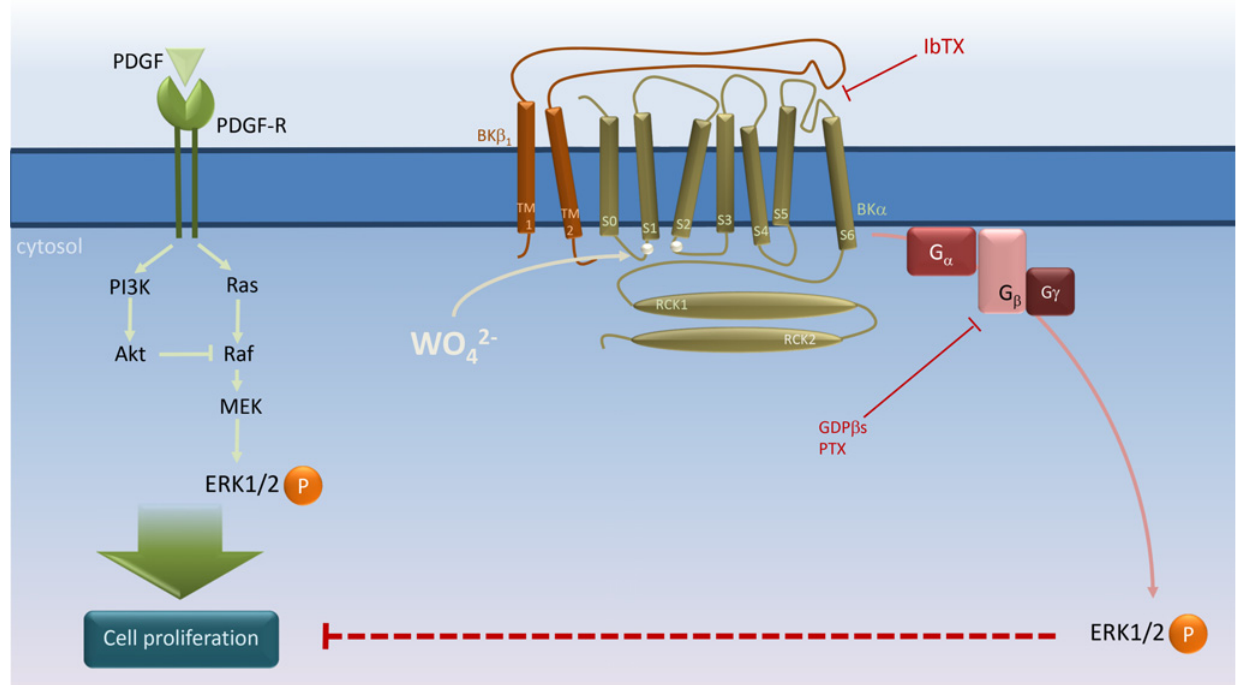
Fig 6. Schematic representation of BK αβ 1 channel ’ s role in tungstate-induced, G i protein-mediated ERK phosphorylation and its interaction with PDGF-stimulated cell proliferation in human vascular smooth muscle. PDGF stimulates both the Ras/Raf/MEK/ERK and the phosphatidylinositol 3- kinase (PI3K)/Akt mitogenic signaling pathways to induce vascular smooth muscle cell (VSMC) proliferation [35]. Tungstate (WO 42- ) binding to the BK channel α subunit at a site involving residues of the Voltage Sensor Domain (silver circles in the S0 – S1 and S2 – S3 linkers) [14, 26] promotes activation of the voltage sensor and channel gating in a β 1 subunit-dependent manner, and subsequently, activation of PTX-sensitive G proteins to induce ERK phosphorylation and inhibition of PDGF-stimulated VSMC proliferation. Binding of iberiotoxin (IbTX) to the external mouth of the channel in close proximity to the β 1 extracellular loop, which plays an important role in the modulation of voltage sensor activation and gating of the BK channel [21, 46 – 53], may impair the conformational changes in the BK αβ 1 channel produced by tungstate to prevent the coupling of channel gating to G protein activation without the need of K + conduction. For further details, please see